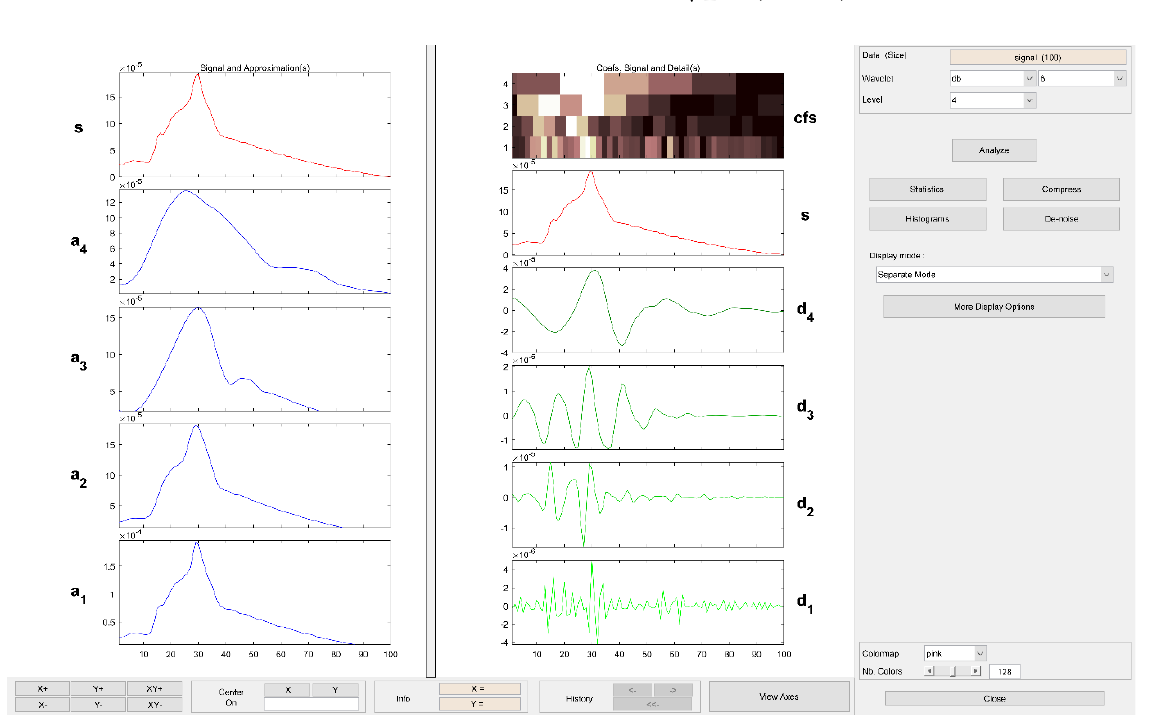
Figure 6. Detail and approximation signals extracted by wavelet